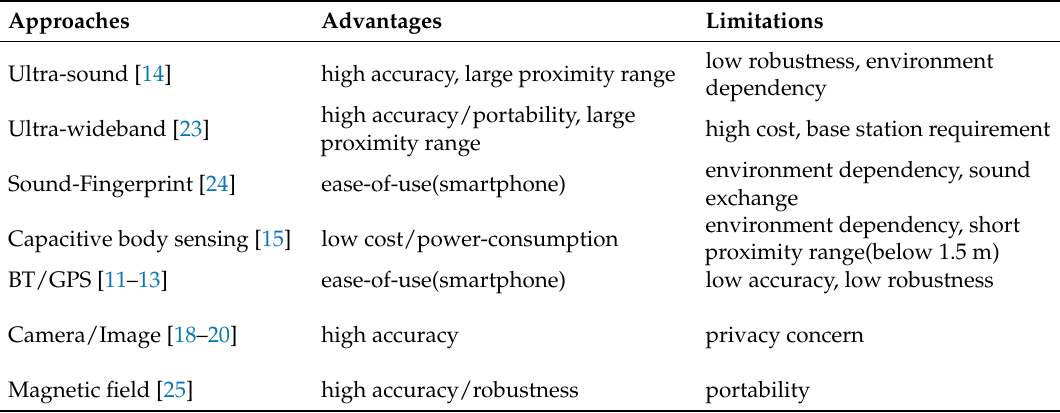
Table 1. Potential proximity sensing technique for social